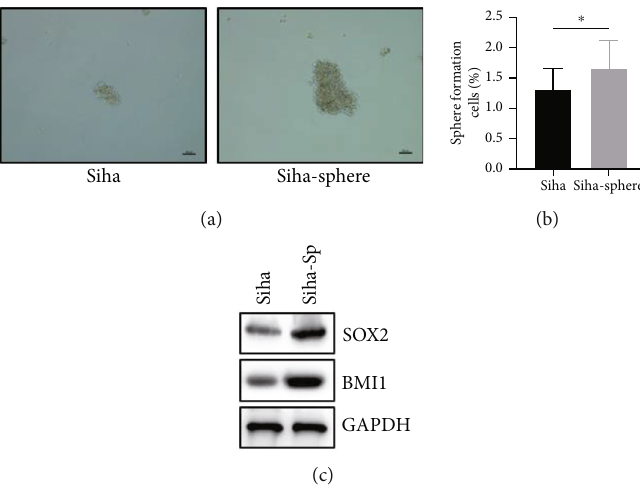
Figure 1: The ability of cell stemness maintenance in Siha sphere is signi fi cantly higher than that in parental cells. (a) The sphere formation ability was signi fi cantly enhanced in the Siha sphere group compared with the Siha group. (b) The enrichment of tumor stem cells signi fi cantly enhanced sphere formation e ffi ciency in the Siha sphere group compared with the Siha group. (c) Western blot was performed to detect protein levels of SOX2 and BMI1 in Siha cells and Siha